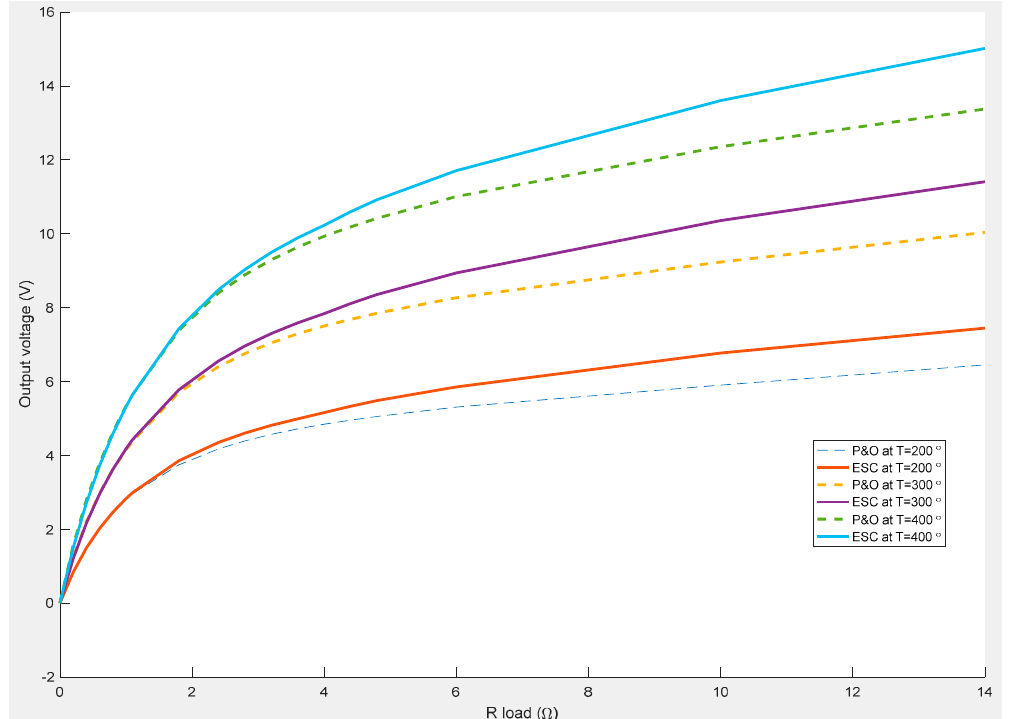
Figure 15. The comparison between the output voltages of ESC and P&O based models.